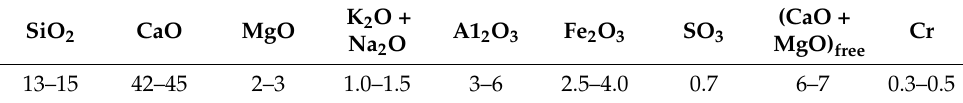
Table 3. Chemical composition of cement kiln dust,